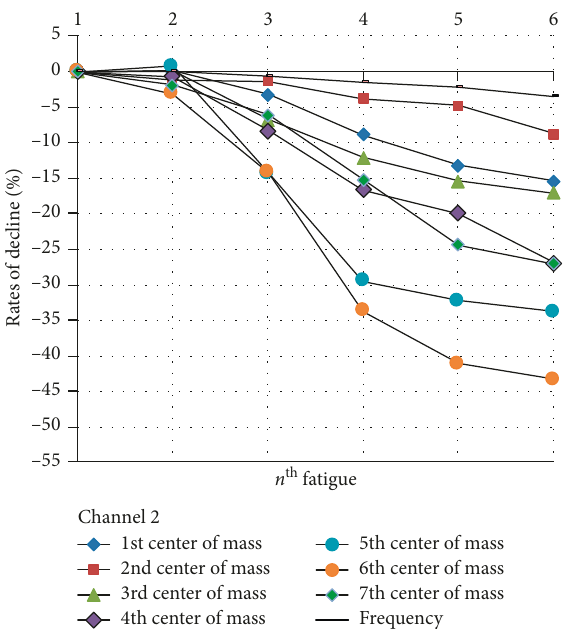
Figure 21: The declined rates in channels 2 with 7 central points in 4 fatigue levels.